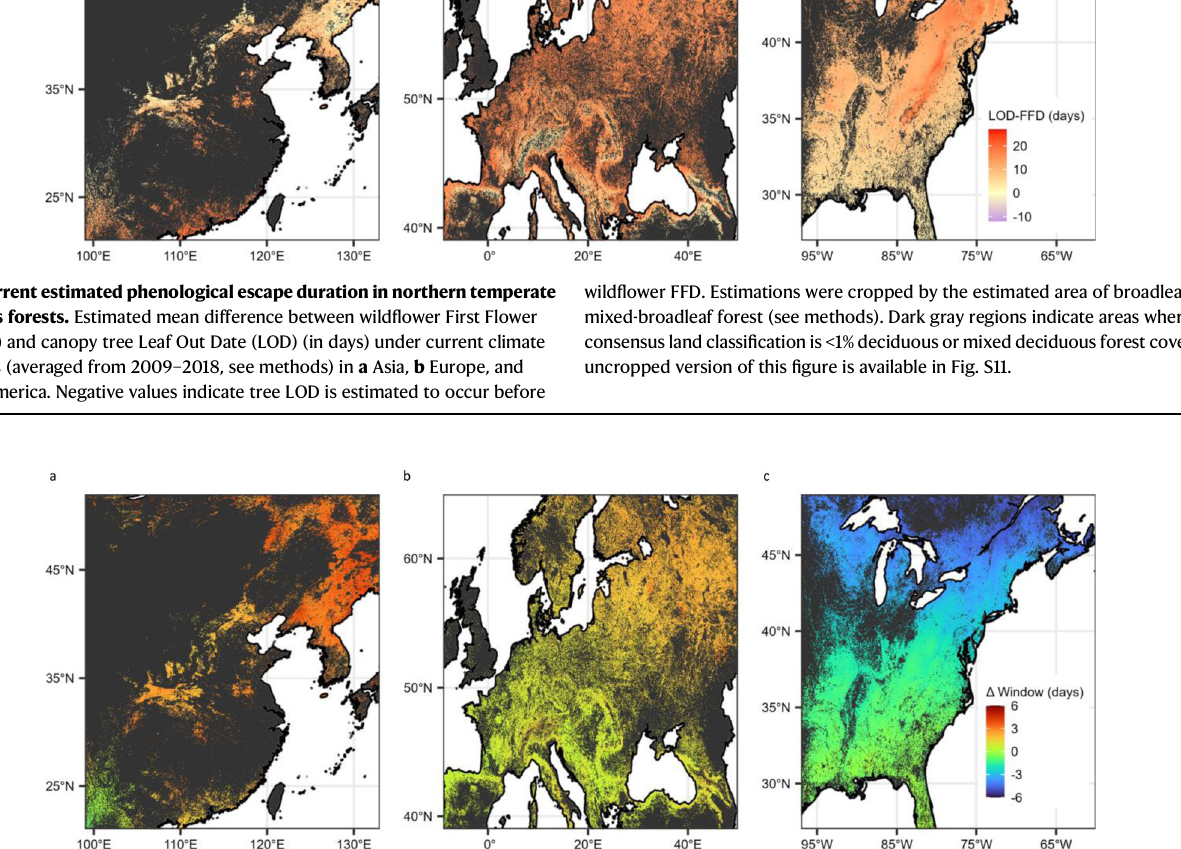
indicate where it is expected to decrease (particularly in northern North America). Dark gray regions indicate areas where the consensus land classi fi cation is <1% deciduous or mixed deciduous forestcover. Anuncropped version of this fi gure is available in Fig. S12.